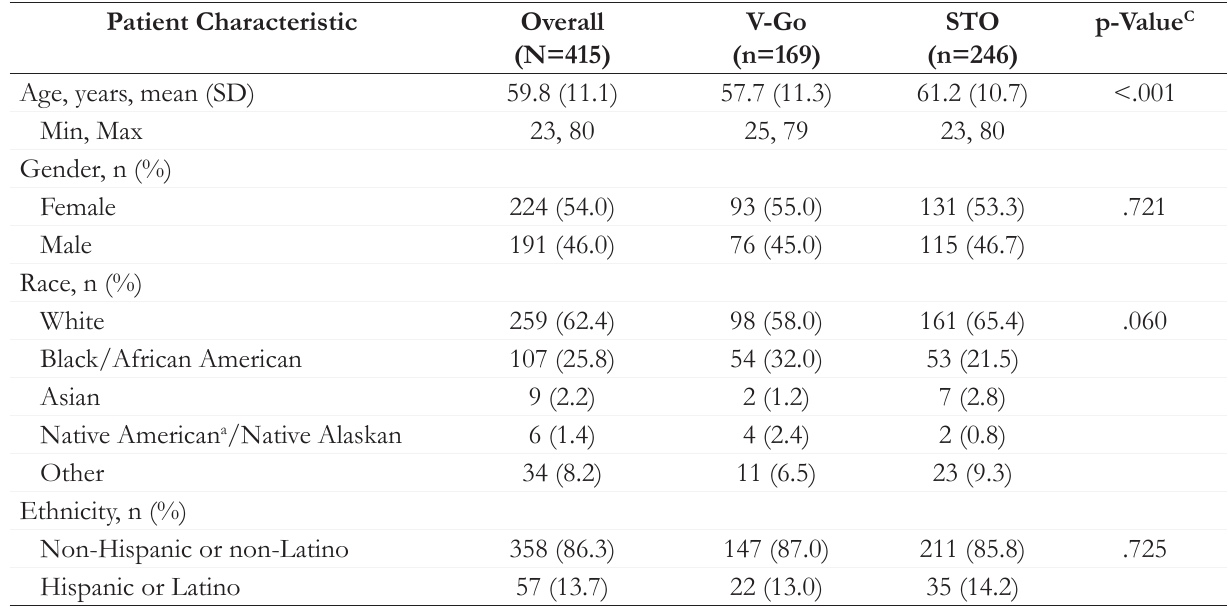
Table 1. Patient Demographic and Baseline Characteristics (Analysis